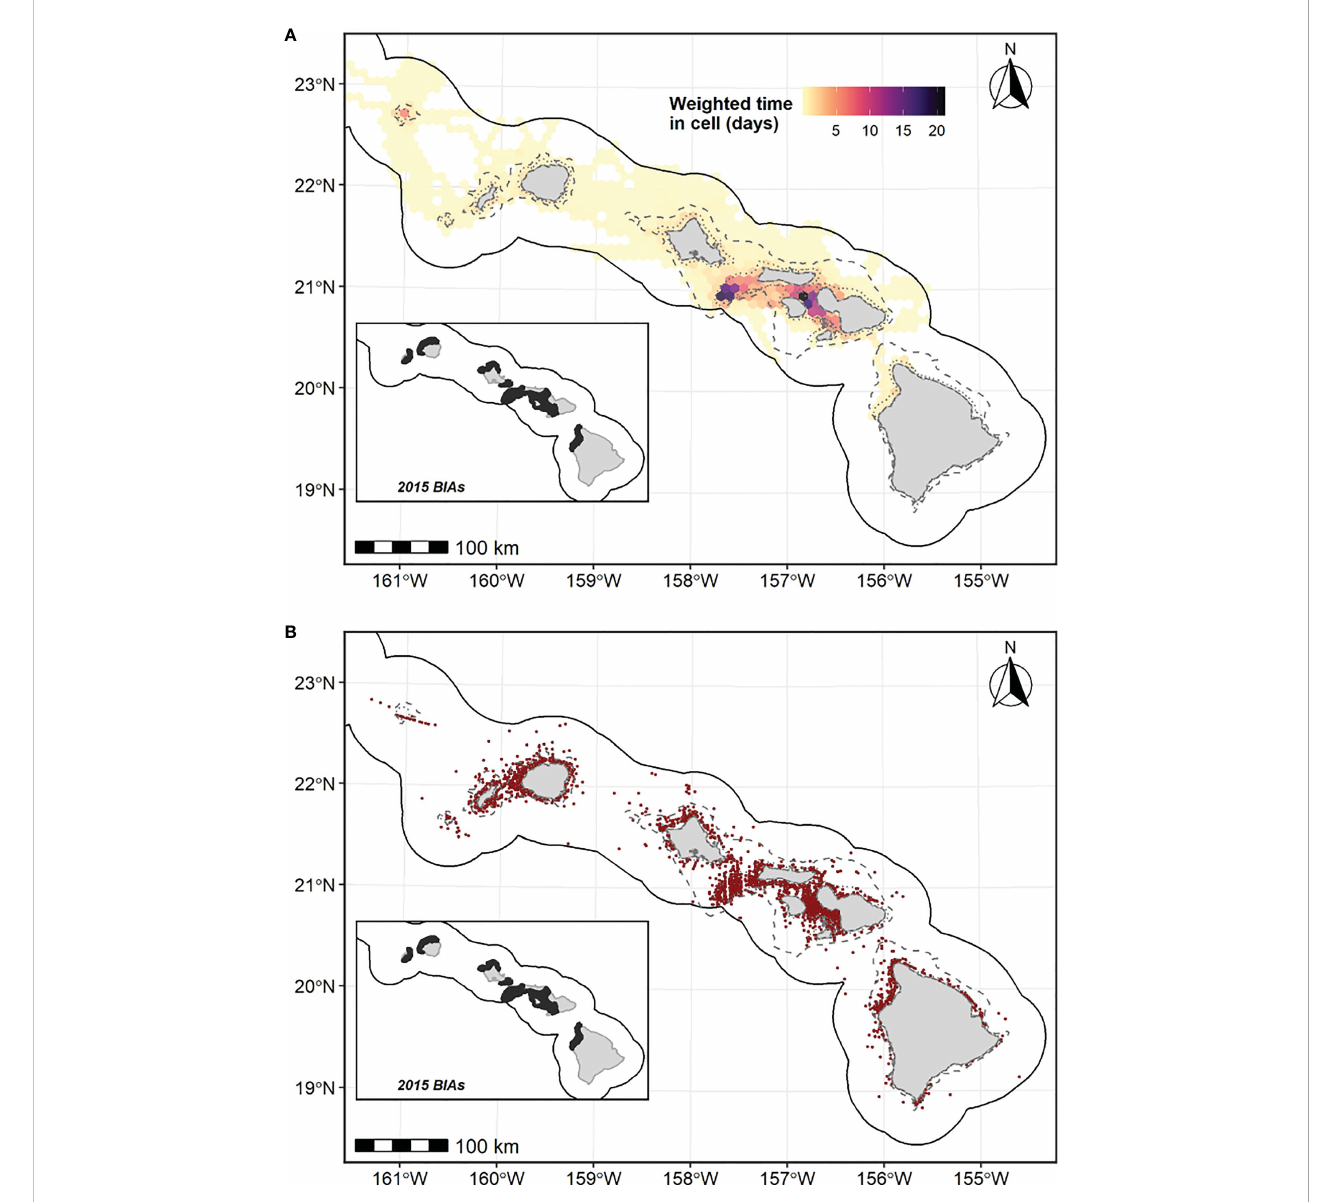
FIGURE 7 (A) Weighted occupancy pattern of satellite tagged humpback whales (n=71) throughout the main Hawaiian Islands; and (B) CRC, NIWC Paci fi c/HDR, Inc., NMFS, and MMRC visual sighting locations (n=2,911, dark red circles). The solid black line represents the breeding area perimeter and 1,000-m and 200-m isobaths are shown as the grey dashed lines and dotted lines, respectively, in each map. Established humpback whale R-BIA boundaries as described by Baird et al. (2015) are shown in the inset maps as black